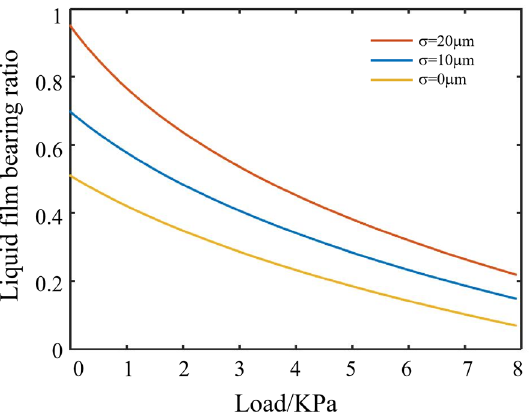
Figure 7. Relationship between liquid film bearing ratio and element pressure under different lap roughness.